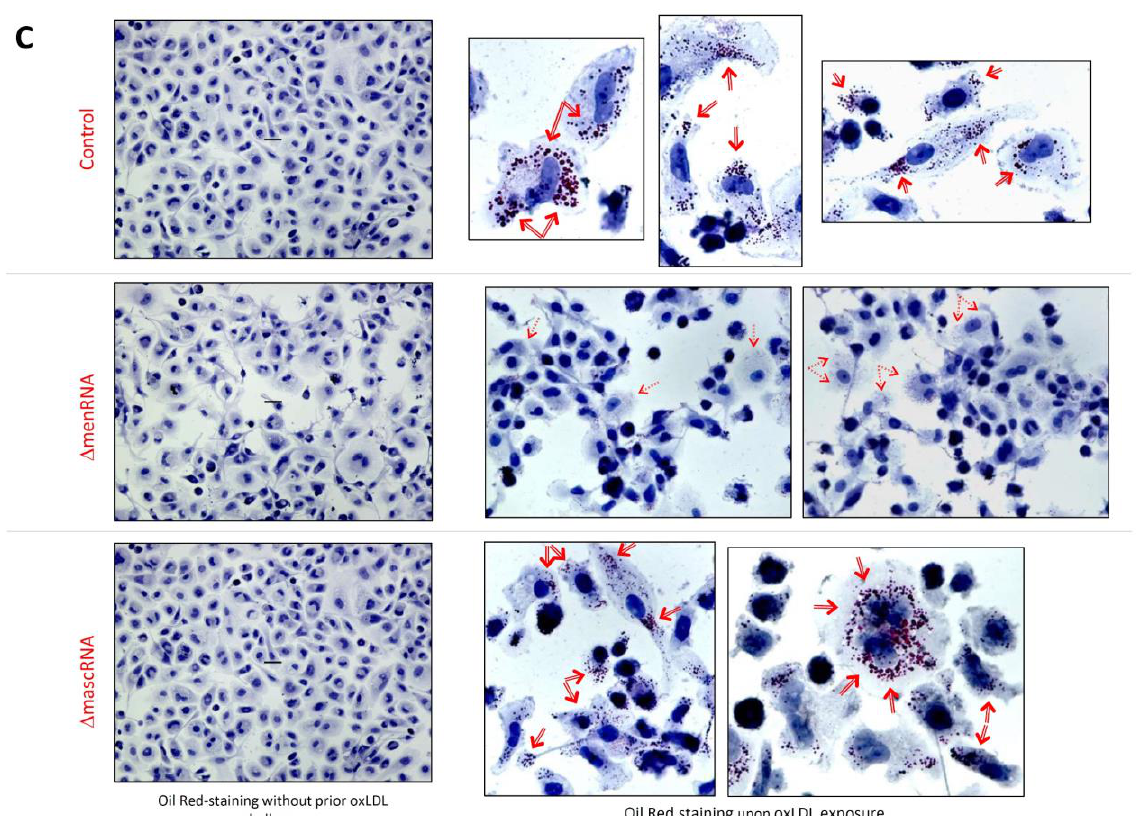
Figure 7. Defective foam cell formation and oxLDL uptake by ∆ menRNA and ∆ mascRNA macrophages. Panel ( Aa ): ∆ mascRNA macrophages displayed an oxLDL uptake pattern indis- tinguishable from that of control cells (intracellular Oil Red-positive OR + vesicles as indicated by red arrows). In contrast, essentially no normal-sized intracellular OR + vesicles were observed in ∆ menRNA macrophages ( p < 0.0001) 24 hrs after oxLDL exposure. A minor number of very small OR + particles is visible in ∆ menRNA cells. It appears these minute particles are not artifacts, and do not represent spontaneous intracellular accumulation of any OR + material in the ∆ menRNA cells, but residues of defective oxLDL endocytosis since they do not show up without prior oxLDL challenge (panel ( C )). Panel ( Ab ): Quantification and statistics of OR + vesicles in the different cell clones. Panel ( B ): The striking defect of oxLDL uptake by ∆ menRNA macrophages is paralleled by loss of scavenger receptors CD36, MCAM (CD146) [67], MSR1, and OLR1 (LOX1) [68]. In contrast, the immunoregu-latory lectin receptor CD93 [52] is ~80-fold upregulated in PMA-generated ∆ menRNA macrophages compared to controls, an effect similarly observed (~35-fold induction) in unstimulated ∆ menRNA monocytes (Figure 8). Bar graphs show means ± SE from four biological replicates. Please note the graphs in panel B display TaqMan data (normalized to control) from PMA-differentiated monocytes (macrophage clones), whereas Figure 8 displays RNA-seq data (FPKM values) from the respective undifferentiated monocyte